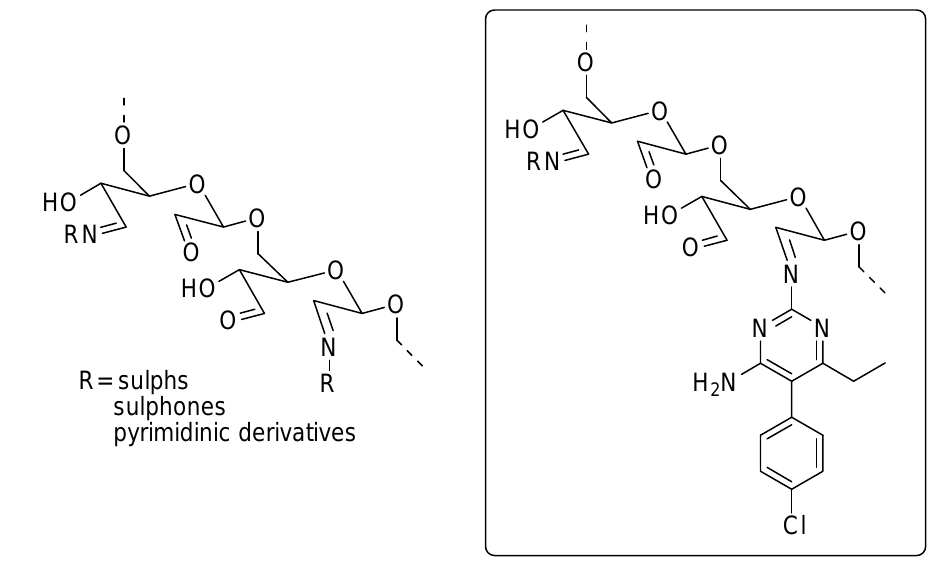
Figure 13 . Oxidized polysaccharides applied at the development of